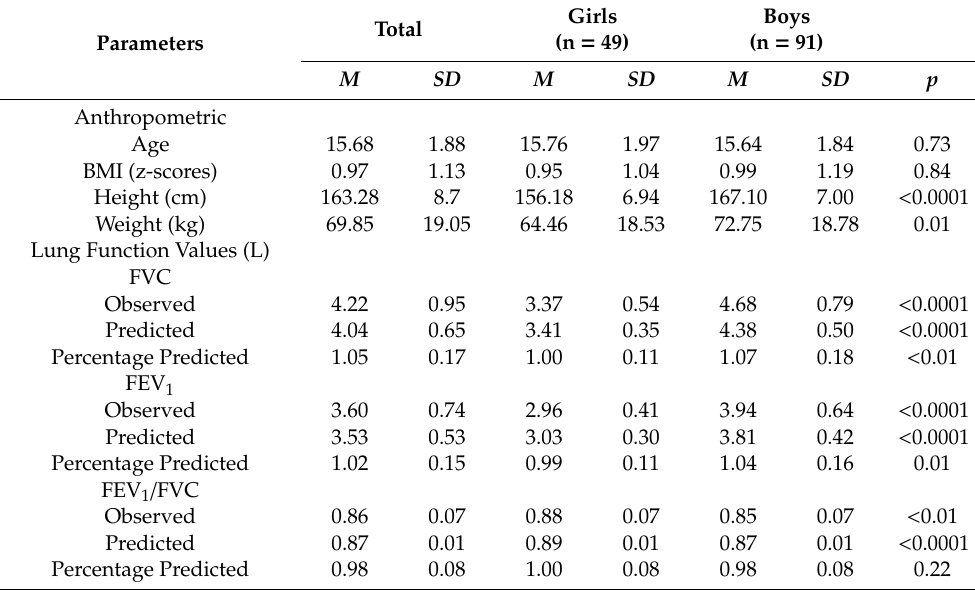
Table 3. Mean values of age, anthropometric and lung function values, hired Latinx child farmworkers in North Carolina (n =